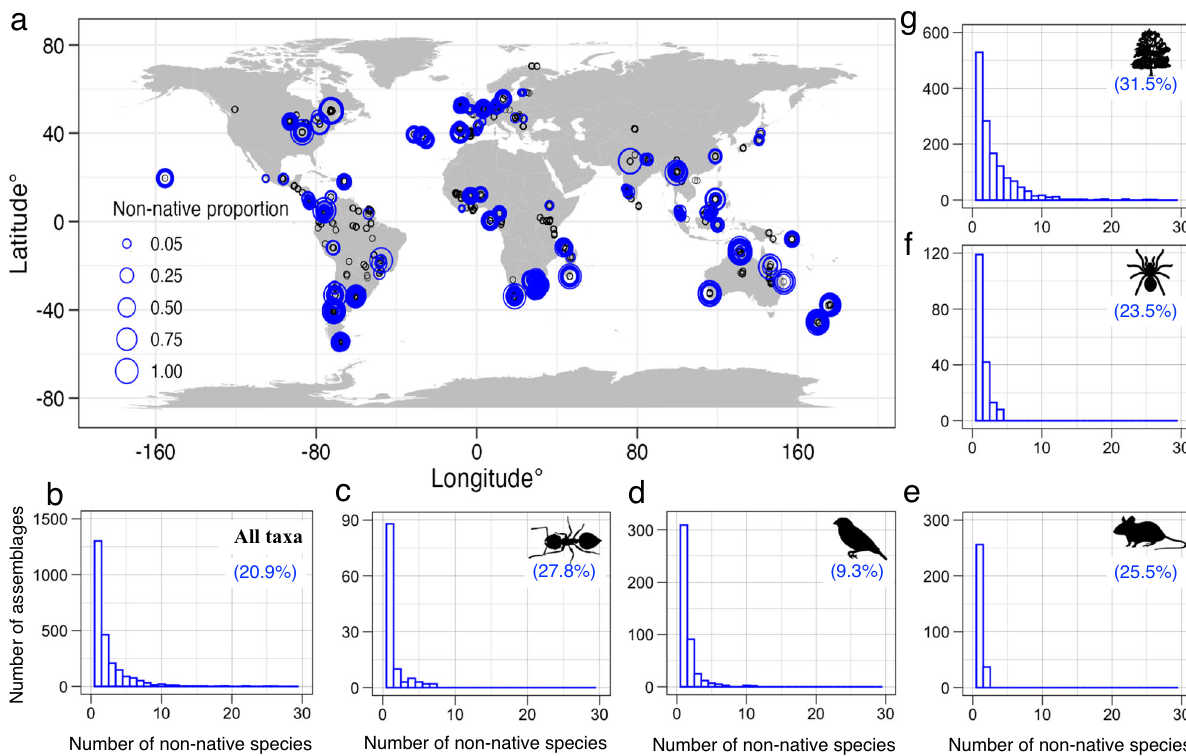
Fig. 1 | Geographic distribution of local assemblages and histograms of the numberoflocalassemblageswithatleastonenon-nativespecies.a distribution of assemblageswith atleast one non-native species(blue circles) and siteswithout non-native species (black circles) for all fi ve focal taxonomic groups. The different sizes of blue circles represent non-native proportions (the number of non-native speciesrelativetoallspecies)inlocalassemblages.Thesubplots( b – g )onlyreferto assemblagescontainingatleastonenon-nativespecies. b histogramofthenumber